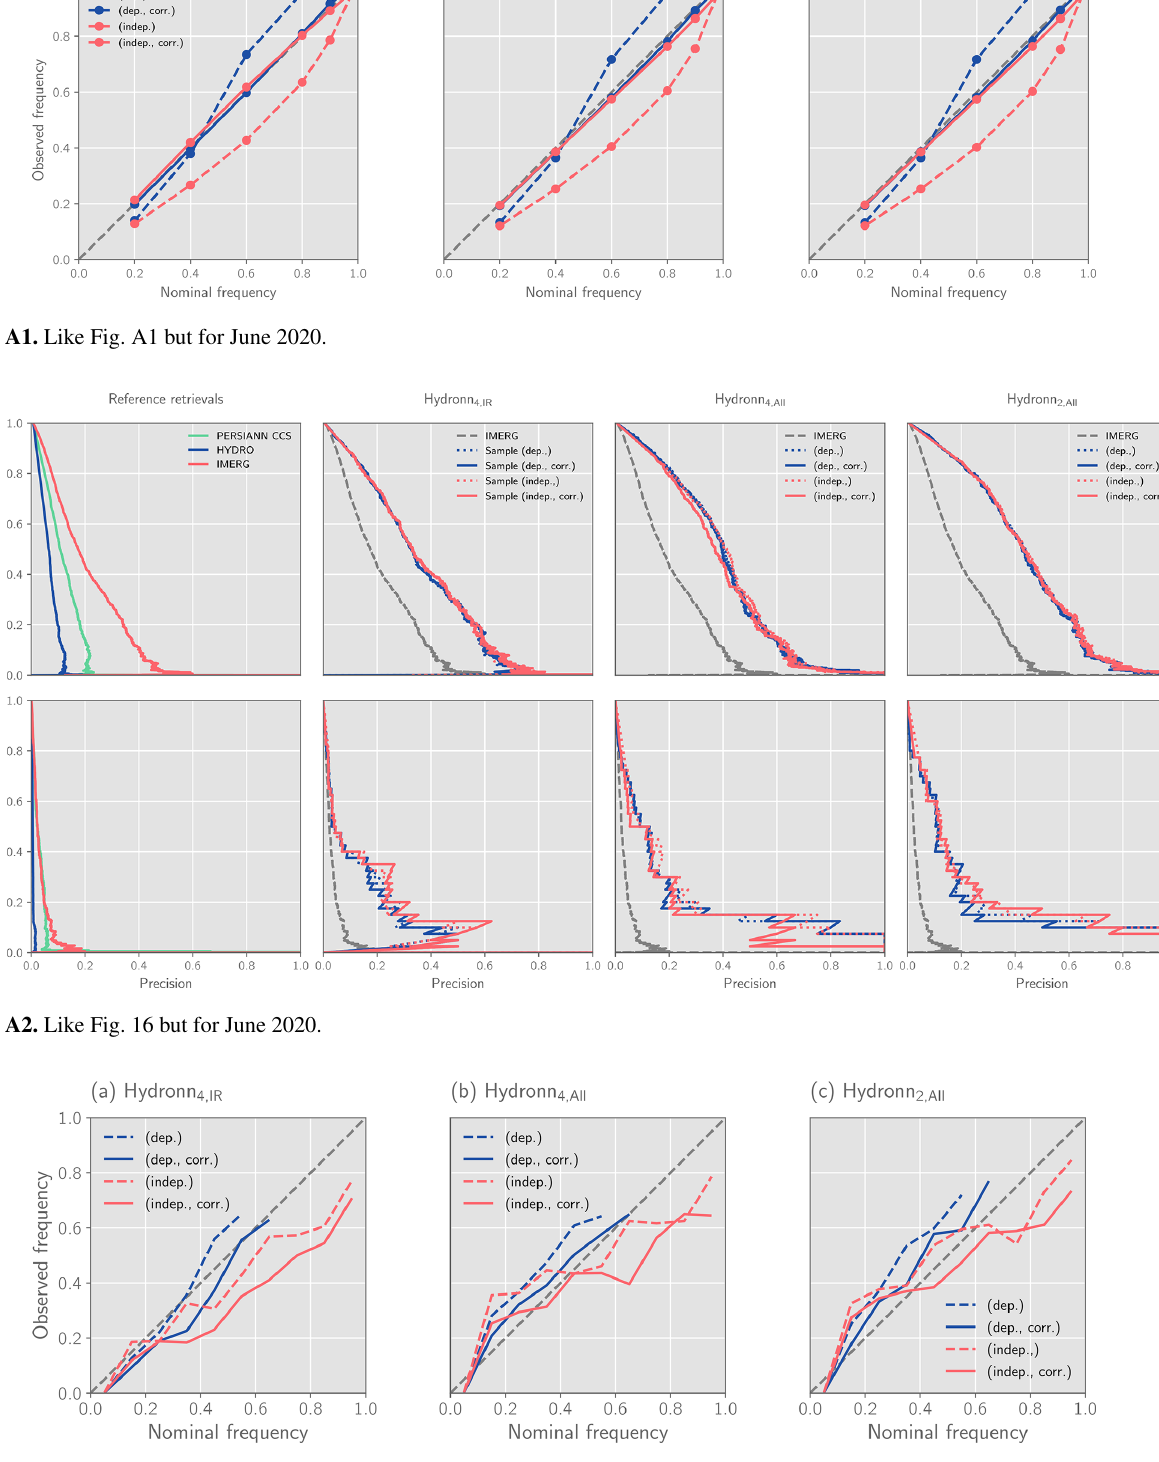
Figure A3. Like Fig. 17 but for June